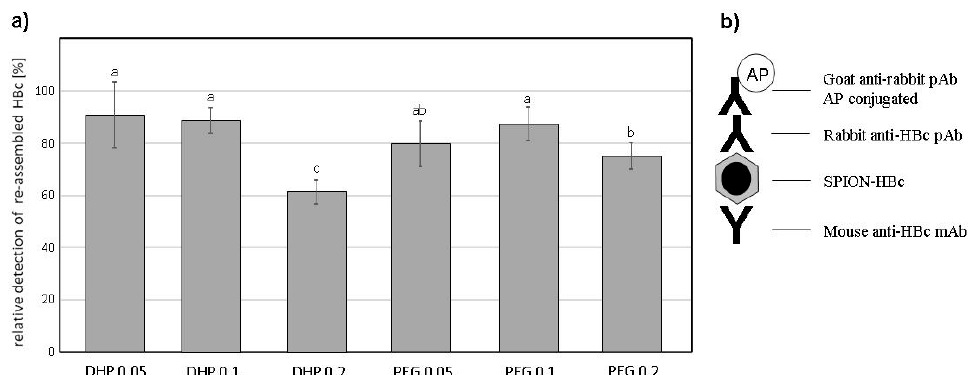
Figure 3. ( a ) HBc re-assembly on SPIONs functionalized with DHP or PEG in different concentrations (mg/mL) in comparison to the initial preparation of plant-derived antigen (100%). Statistically significant differences marked by a letter indexes; ( b ) Scheme of enzyme-linked immunosorbent assay (ELISA) test used for assay of VLP-assembled HBc and SPION-HBc VLPs. AP—alkaline phosphatase.